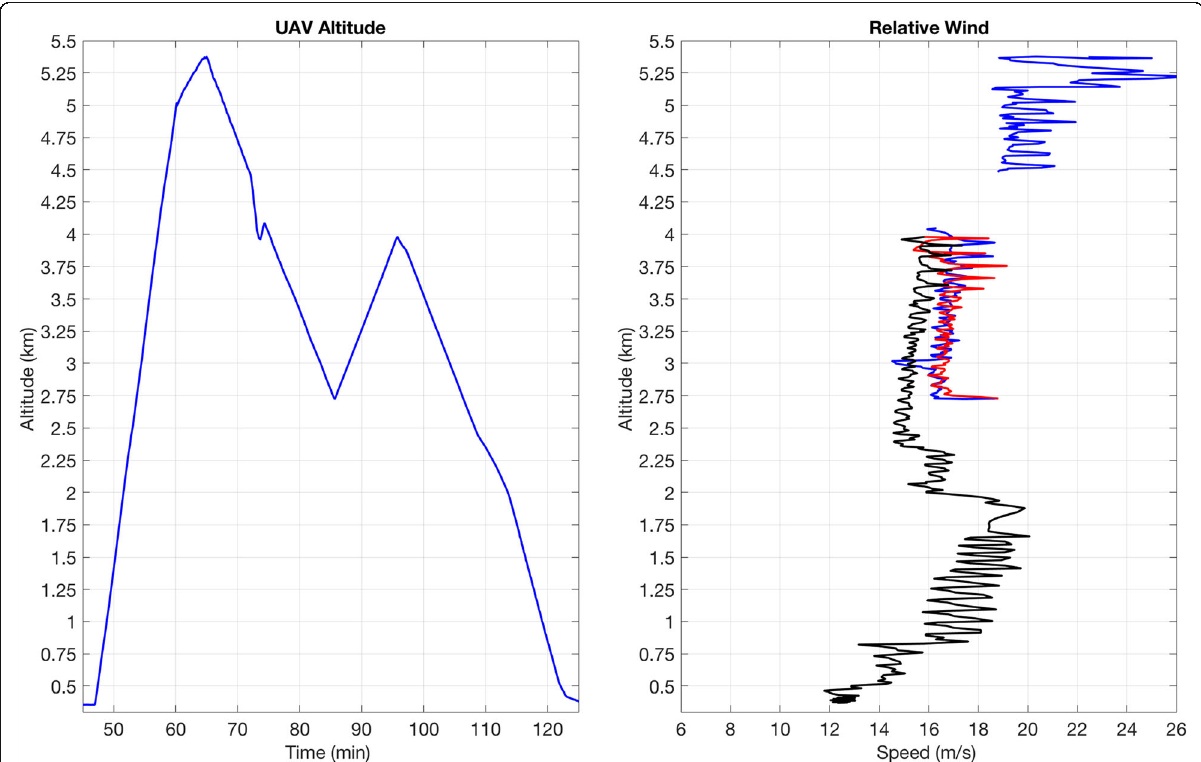
Fig. 14 As in Fig. 11, but for UAV 17. In the right panel , the blue line denotes D1; red line , A2; and black line ,